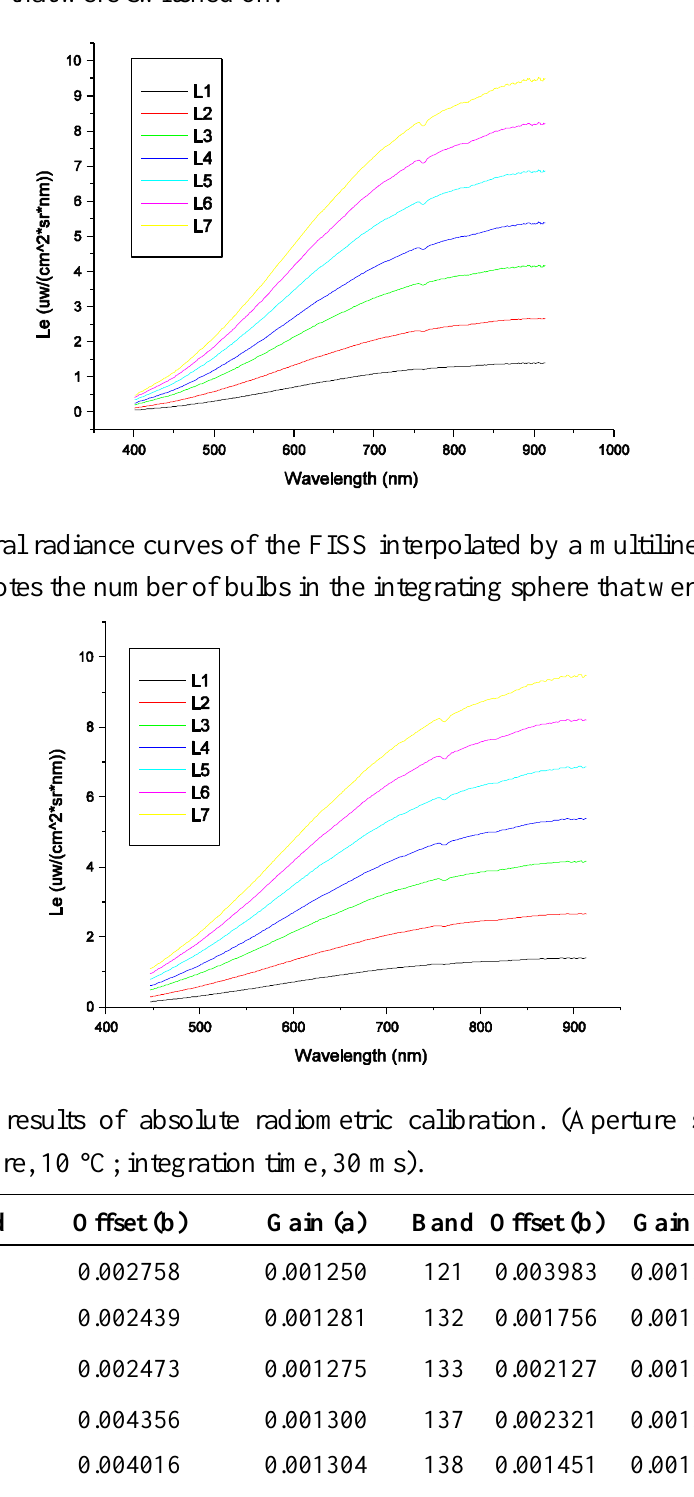
Figure 12. Spectral radiance curves for seven levels obtained by the SVC HR1024 within the spectral region of 400–915 nm. The level number denotes the number of bulbs in the integrating sphere that were switched on.